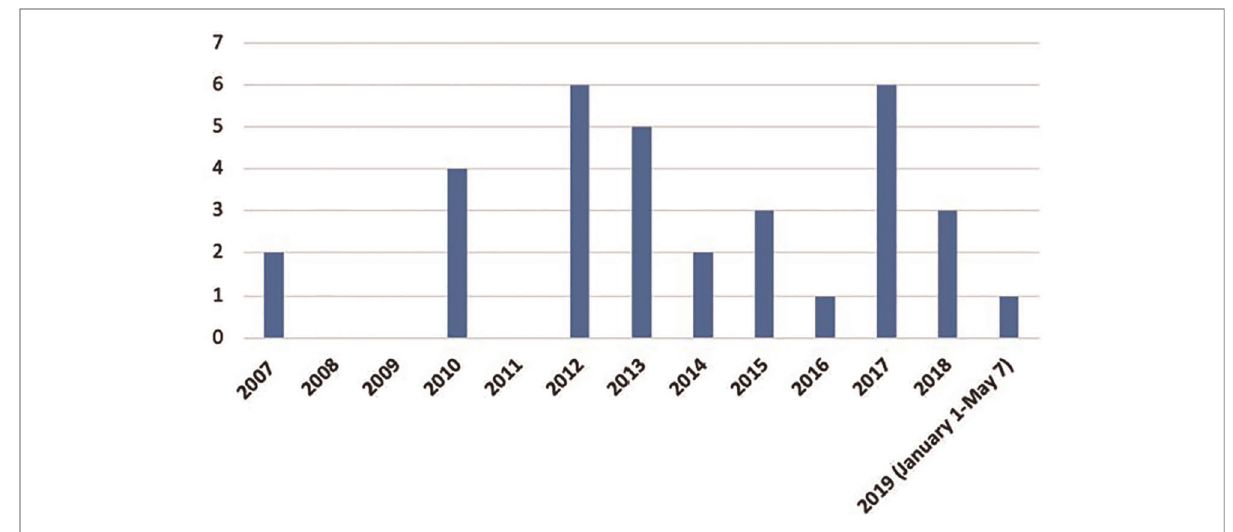
FIGURE 2 Number of articles published per